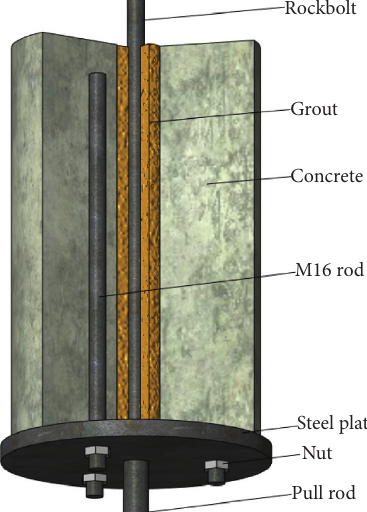
Figure 2: Sample after pouring.